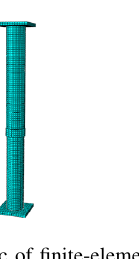
Fig. 14 Schematic of finite-element (FE) model